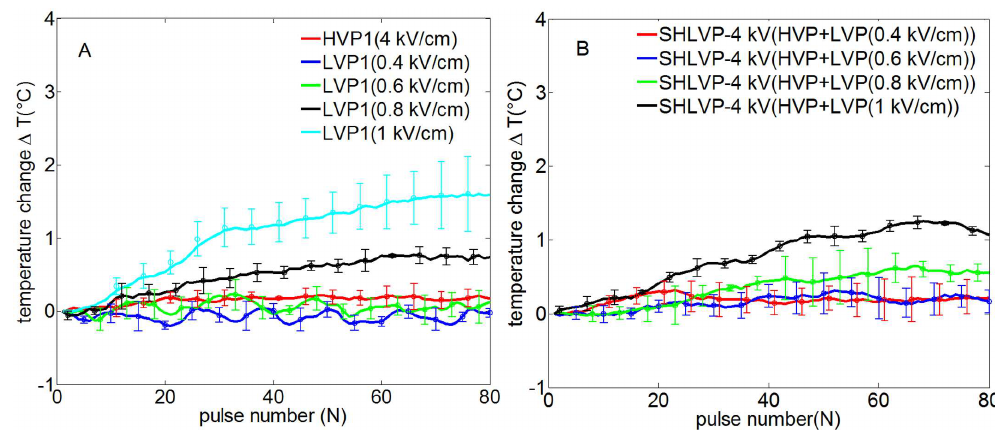
Fig 8. Real-time temperature changes at point 1 as a function of the number of HVPs, LVPs (A) and SHLVPs (B). HVP1: 4 kV/cm, 2 μ s, 80 pulses; LVP1: 0.4–1 kV/cm, 100 μ s, 80 pulses; SHLVP-4 kV: HVPs (4 kV/cm, 2 μ s, 20